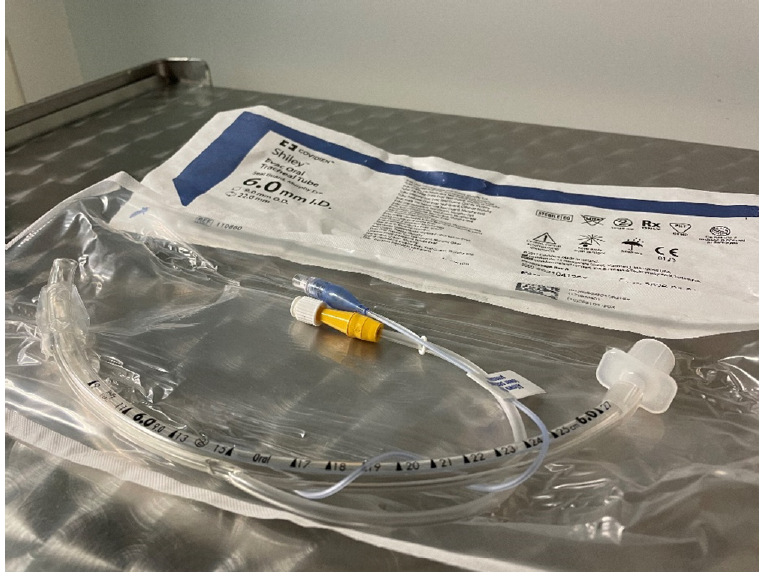
Figure 1. Endotracheal tube with a subglottic suction.